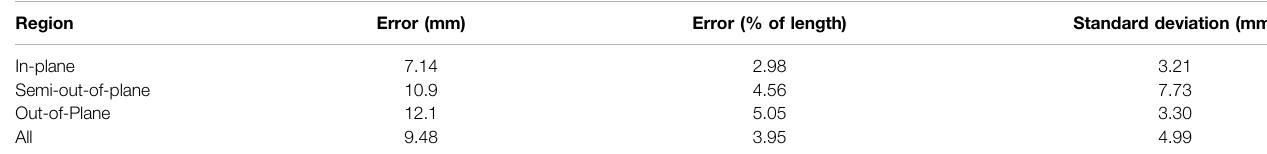
TABLE 2 | Mean positional tip location error together with the standard deviation for the three different